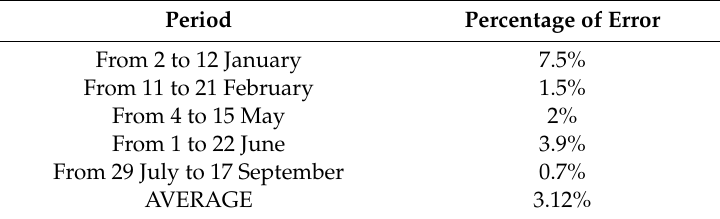
Table 4. Percentage of error for every considered